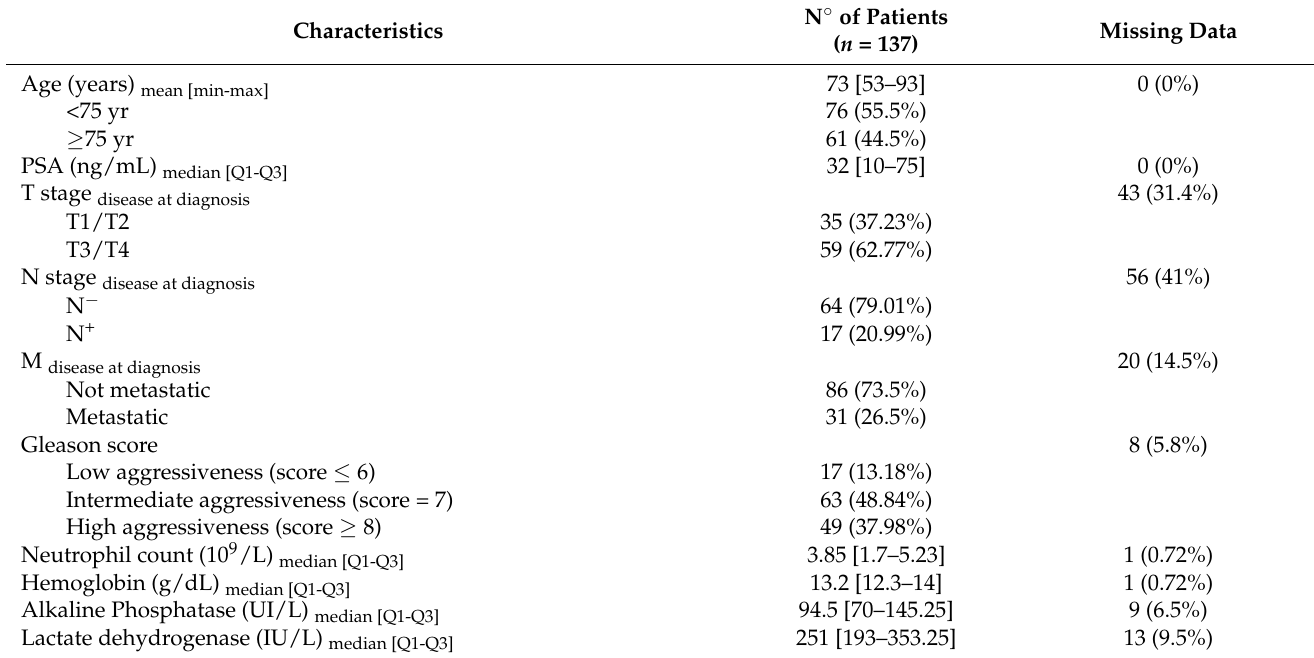
Table 1. Patients’ characteristics at baseline and response to